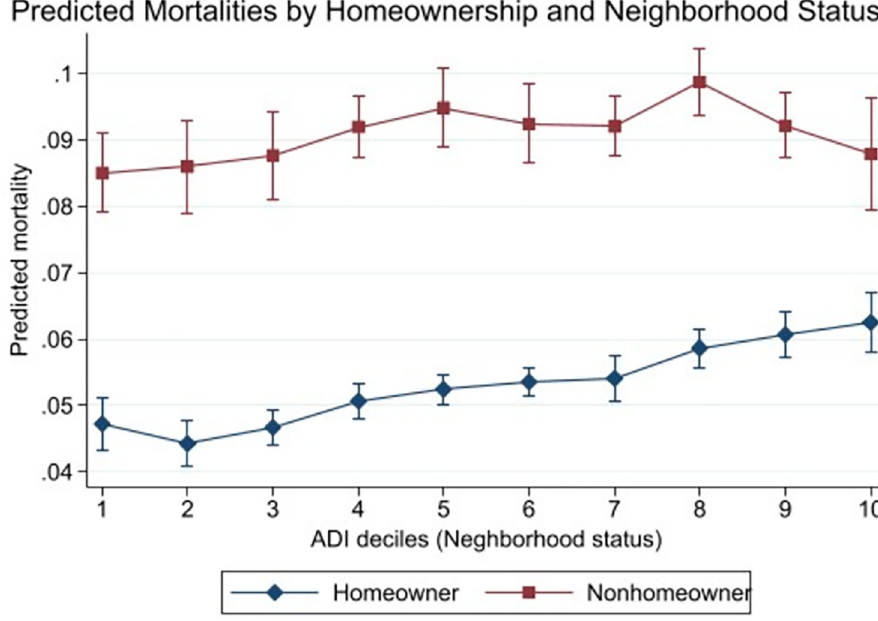
Fig 2. Predicted mortality rates by ADI decile groups, homeowners vs. nonhomeowners among older adults ages 65+. Source: Medicare Health Outcomes Survey, 2014–2015. Note: The predicted mortalities were obtained based on the regression models presented in Table 2. The models were controlled for age (65–69, 70–74, 80–84, 85 or older), sex (male, female), race/ethnicity (non-Hispanic white, non-Hispanic Black, non-Hispanic Asian, Hispanic, other), the number of chronic conditions (none, 1–2, 3–5, 6 or more), BMI (normal/overweight, obese, underweight), difficulties in ADL (none, 1 or more), smoking status (not smoking, smoking), and survey year (2014, 2015).